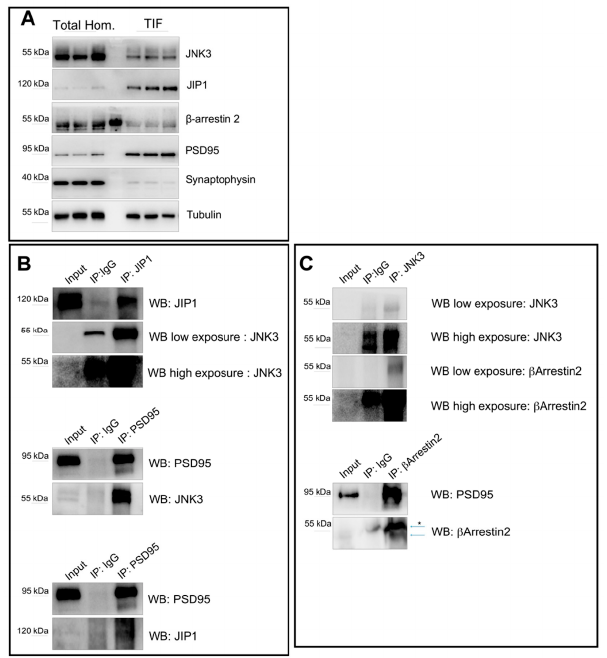
Figure 5. Immunoprecipitation outputs used to assess JNK3–JIP1– β -arrestin2–PSD95 interactions at the synapse. ( A ) Western blots performed on total brain homogenate and Triton-insoluble fraction (TIF) reveal the different amounts of JNK3, JIP1, ß-arrestin2, and PSD95 in the two extracts analyzed. Synaptophysin was used as a control for the purity of the TIF preparation. ( B ) JIP1 was immuno- precipitated from the TIF using JIP1 antibody, and immune complexes were analyzed for the pres- ence of JNK3 (rabbit). Immunoprecipitation with IgG antibody was used as a control. PSD95 was immunoprecipitated from the TIF using PSD95-specific antibody, separated by SDS-PAGE, and